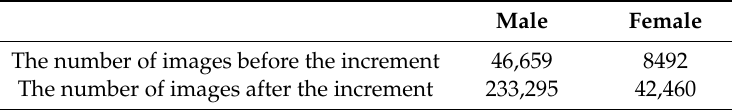
Table 5. The accuracy comparison using various fusion methods in a MORPH dataset.